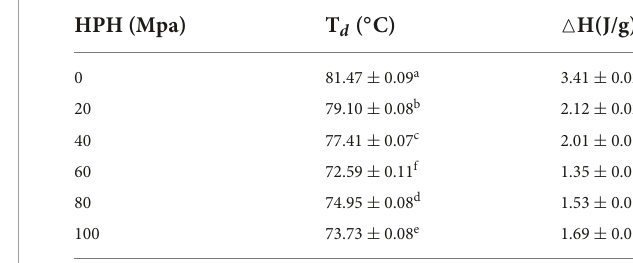
TABLE 2 Effects of high-pressure homogenization (HPH) on the denaturation temperature (T d ) and enthalpy ( (cid:77) H) of enzymatic hydrolyzed soybean protein concentrate (SPC).